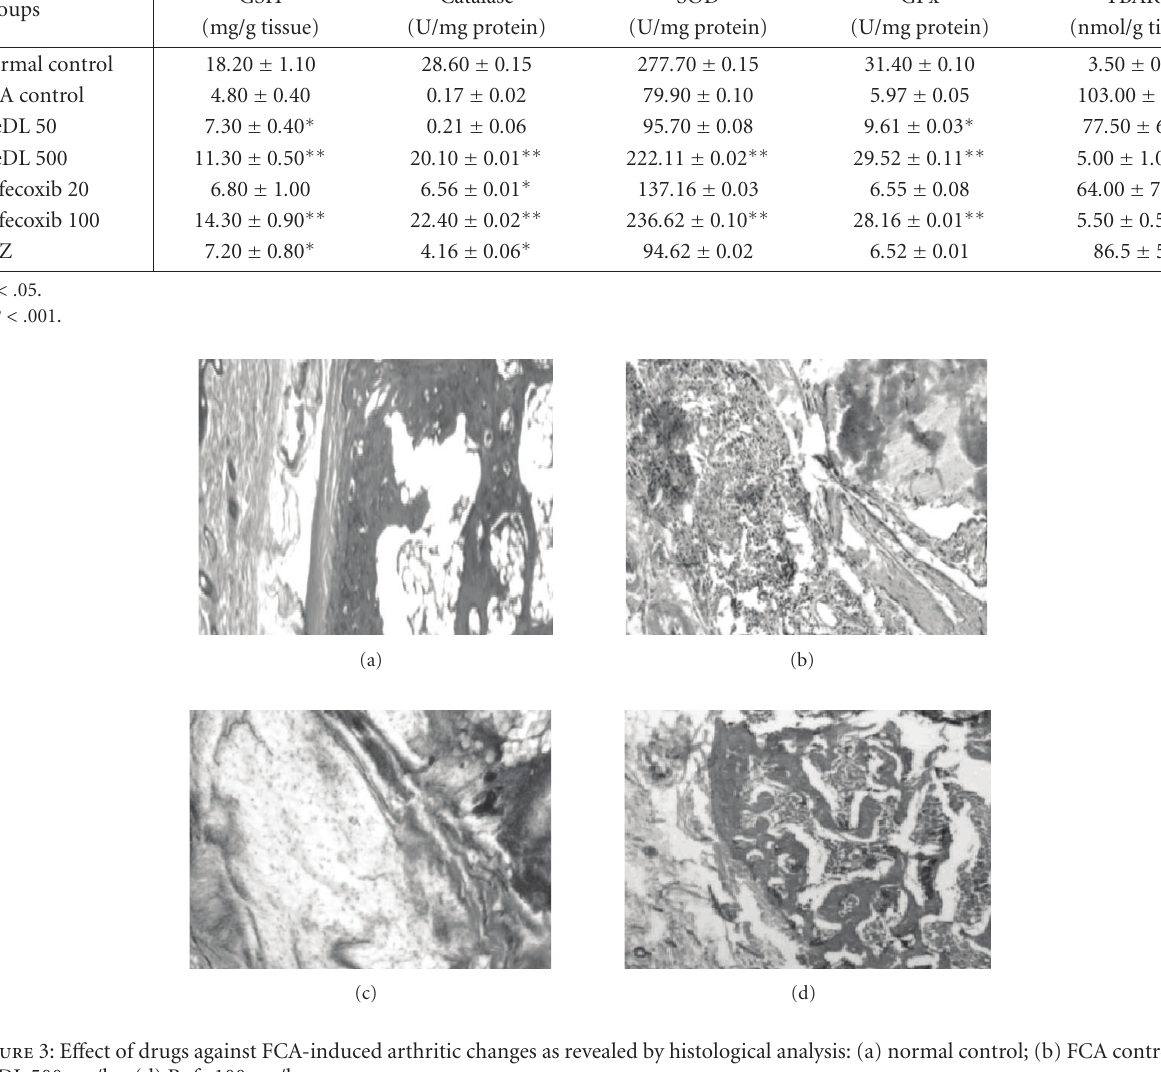
Figure 3: E ff ect of drugs against FCA-induced arthritic changes as revealed by histological analysis: (a) normal control; (b) FCA control; (c) MeDL 500mg/kg; (d) Rofe 100